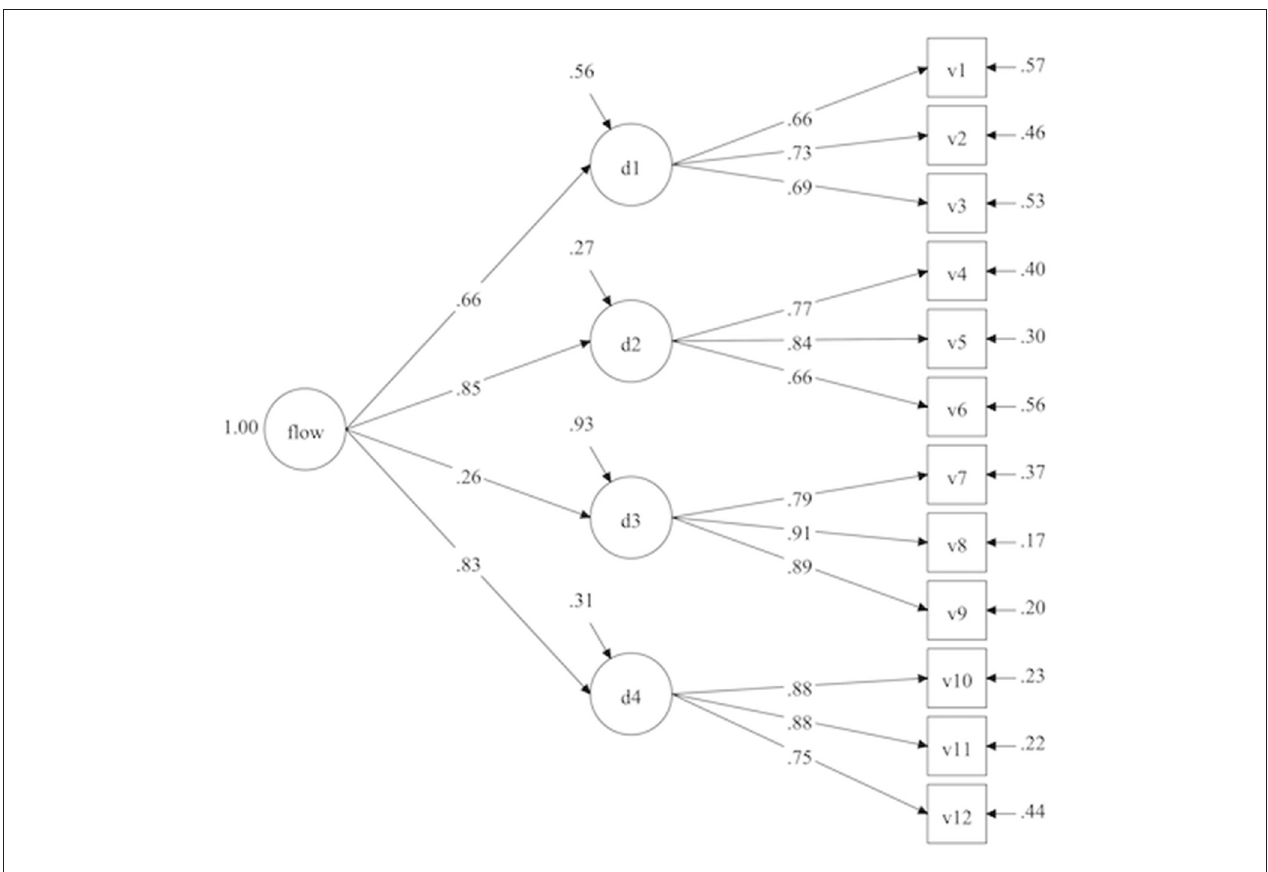
FIGURE 3 | Second order factor.